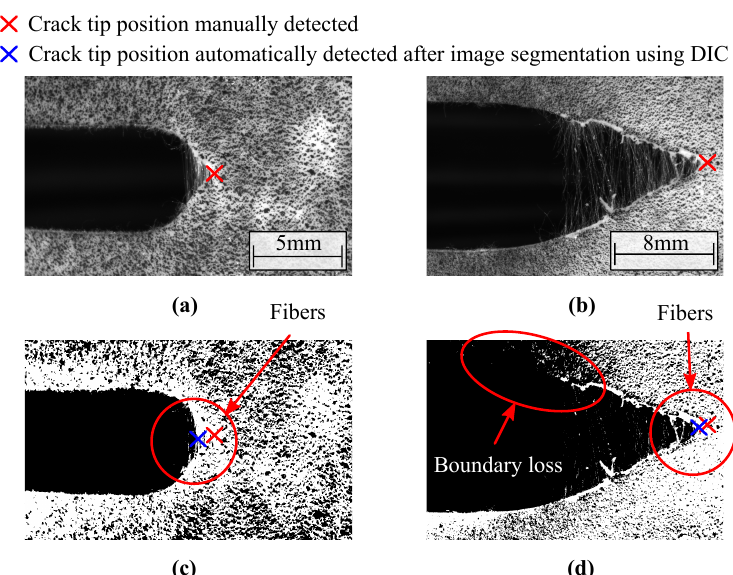
Figure 8. Image segmentation problematic. Captured image of soft composite with fibers oriented at ( a ) 0 ◦ and ( b ) 90 ◦ , and image segmentation considering ( c ) θ = 0 ◦ and ( d ) θ = 90 ◦ . The red cross symbol depicts the manually detected crack tip position while the blue cross depicts the automatically detected crack tip position using DIC after image segmentation.